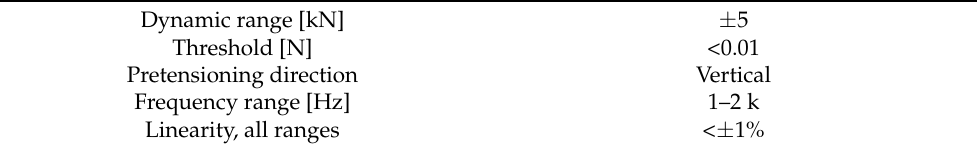
Table 2. Characteristics of the Kistler 9257A dynamometer.